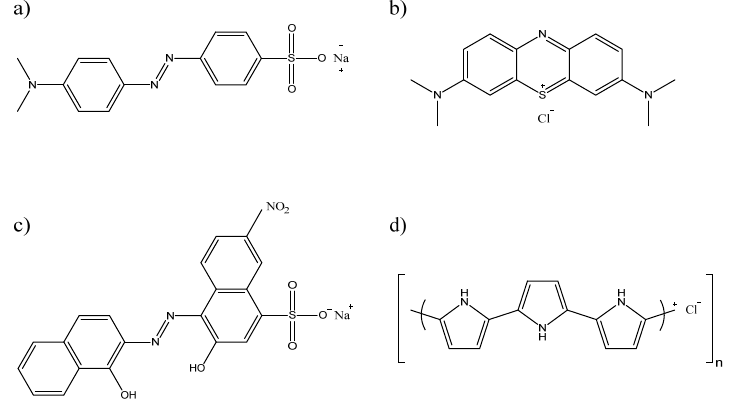
Figure 7. Chemical structural formulas of ( a ) Methyl Orange, ( b ) Methylene Blue, ( c ) Eriochrome Black T dye and ( d ) polypyrrole.